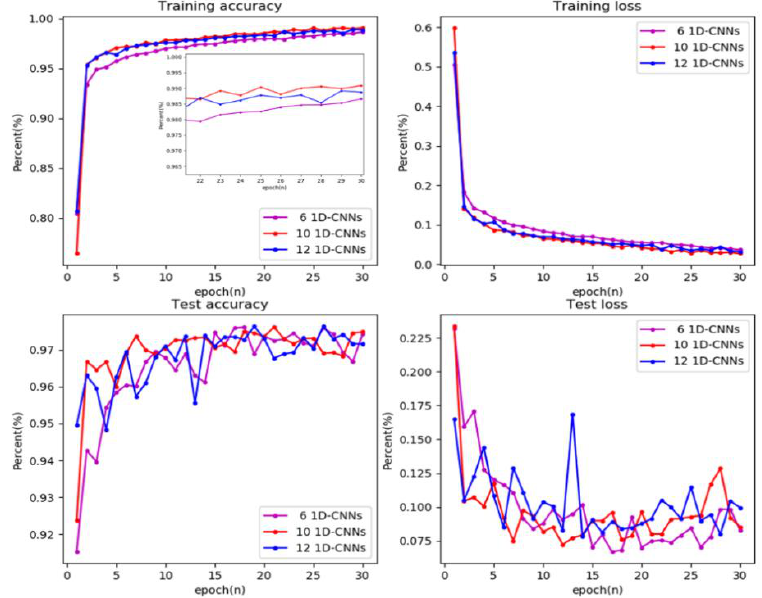
Figure 10. Training and test results of models with different convolutional layers.